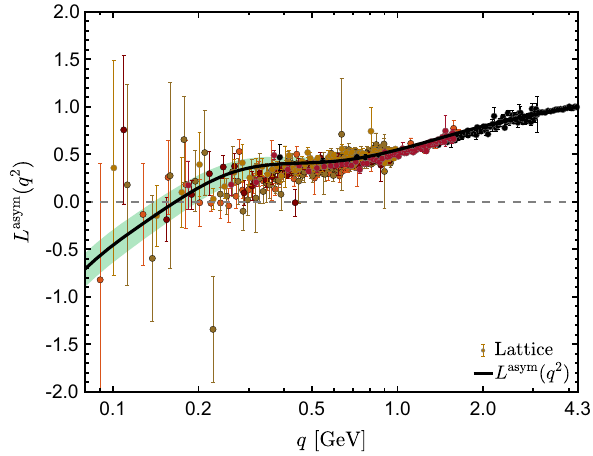
Fig. 3 Lattice data for L asym ( q 2 ) (circles) from [63,64], and the fit given by Eq. (5.3). The green shaded band shows a spread in the L asym ( q 2 ) of approximately 0 . 37 at zero momentum, and reduces to 0 . 20 at 300